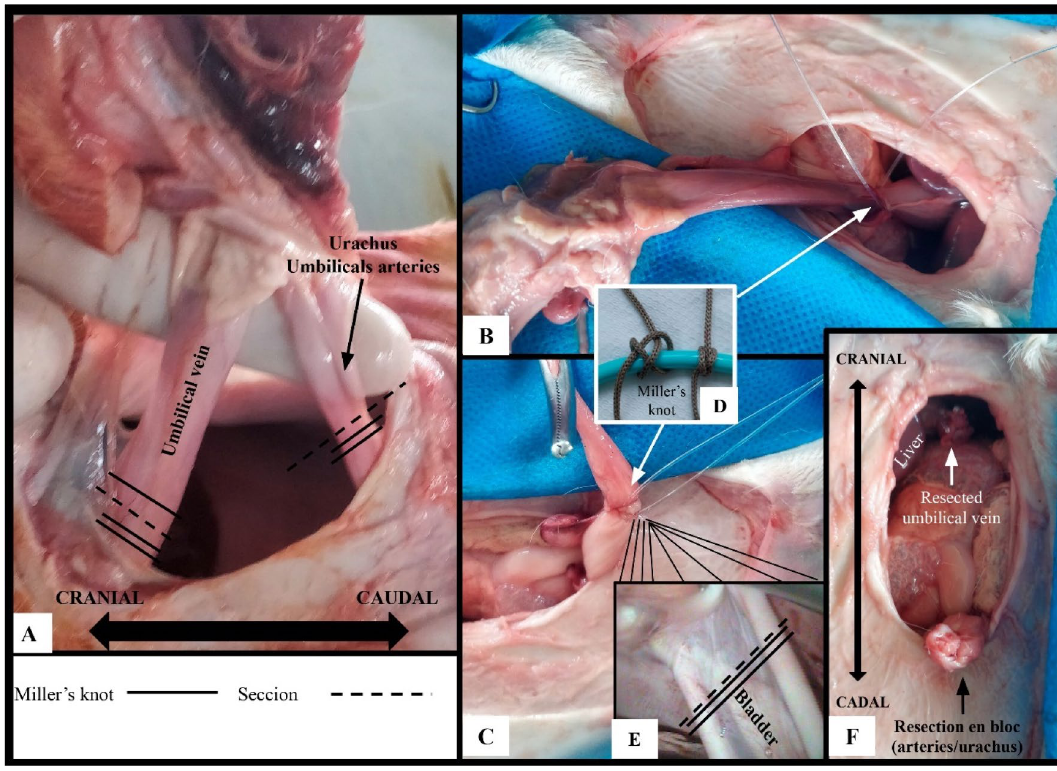
Figure 4. Intra-abdominal resection of the umbilical vein and urachus of bovine fetuses using celiotomy.